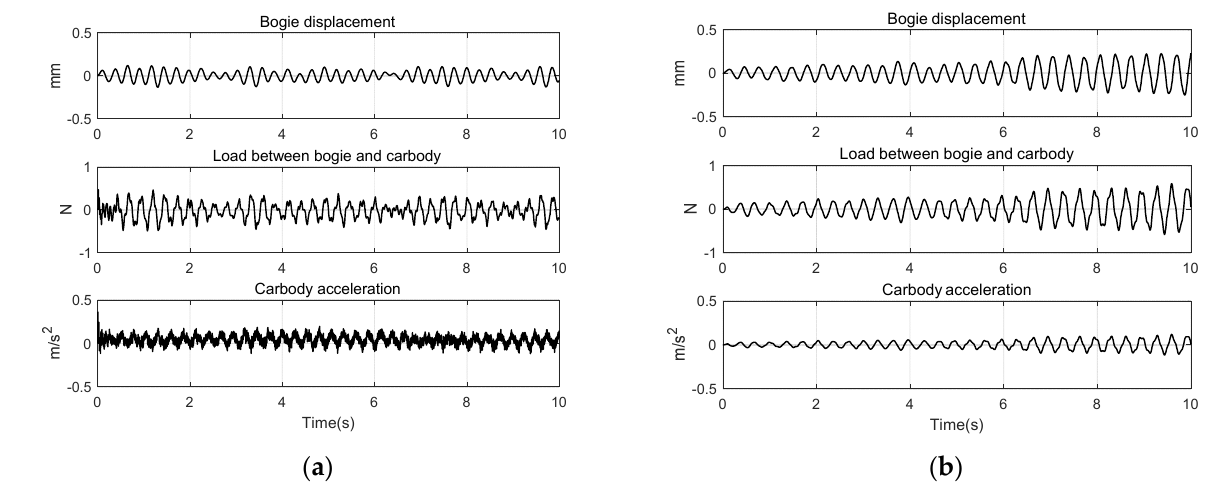
Figure 7. Dynamic characteristics in vertical direction: ( a ) experiment, ( b ) simulation.